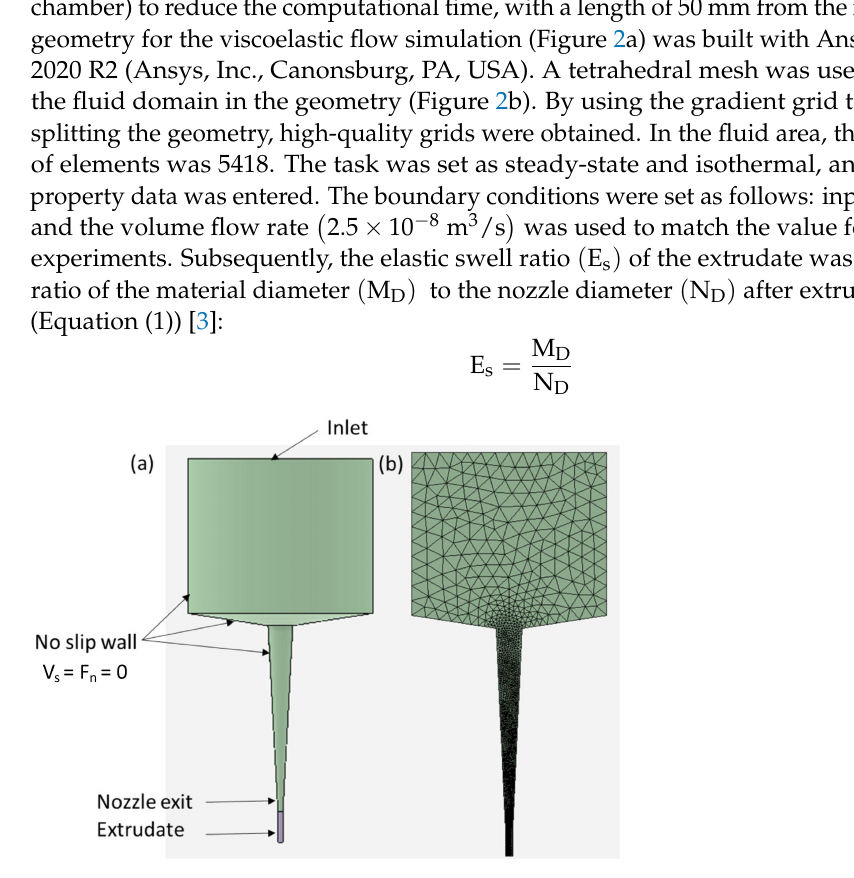
Figure 2. A schematic diagram of the printer nozzle and sample chamber, showing: ( a ) the flow domain’s essential boundary conditions and ( b ) the mesh of the convergent region, as well as the nozzle